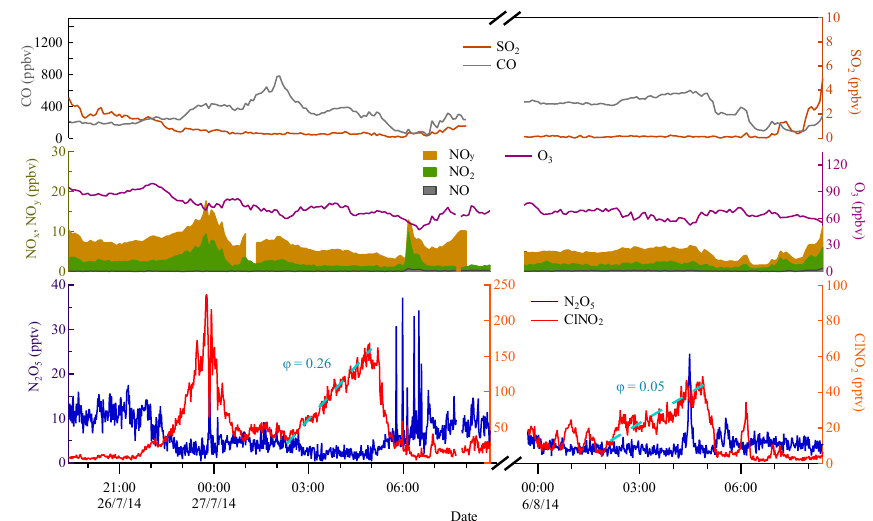
Figure 9. Examples of ClNO 2 yields determined for two cases on 27 July and 6 August 2014. The ClNO 2 mixing ratios increased steadily, while those of NO x , O 3 , and SO 2 did not change significantly during the studied